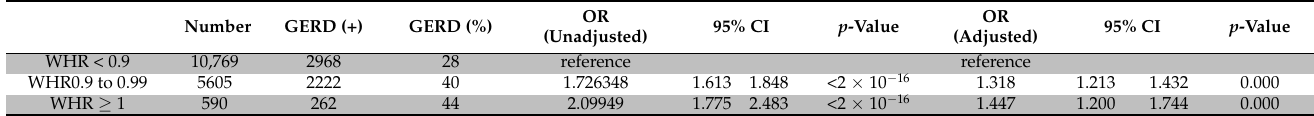
Table 3. Different WHR with the risk of